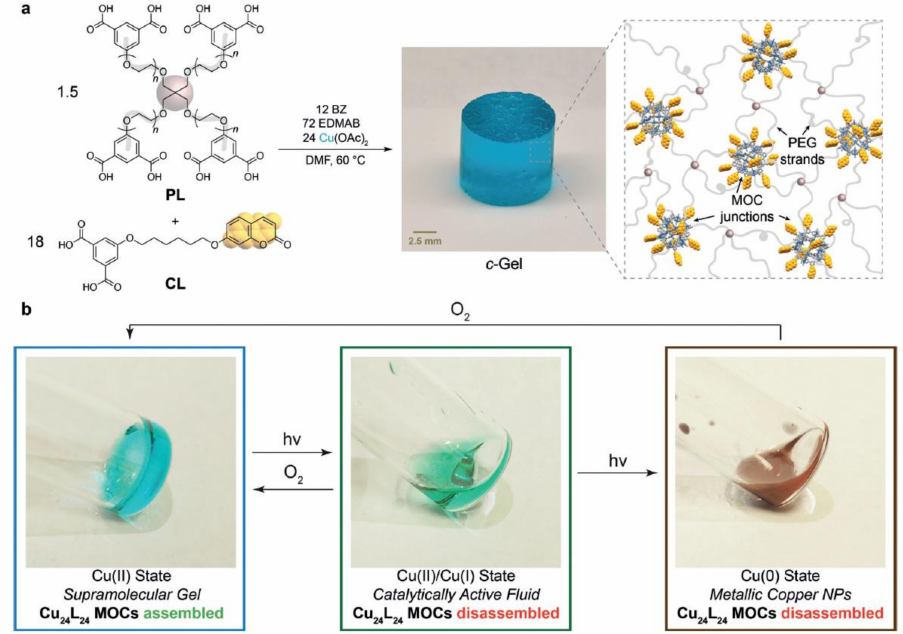
Figure 42. ( a ) Schematic illustration of Cu 24 L 24 -based metal-organic cages/polyhedra (MOCs) with coumarin-functionalized junctions. ( b ) Reversible switching of c-Gel between redox states (Cu II , Cu I , and Cu 0 ) with corresponding gel–sol transitions and differences in catalytic activity. Adapted from [219], with permission from John Wiley and